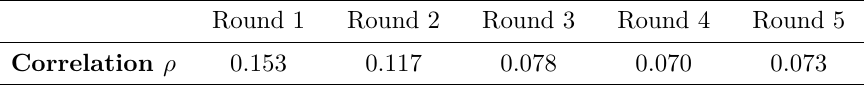
Table 1: Mean correlations for the leakages corresponding to Section